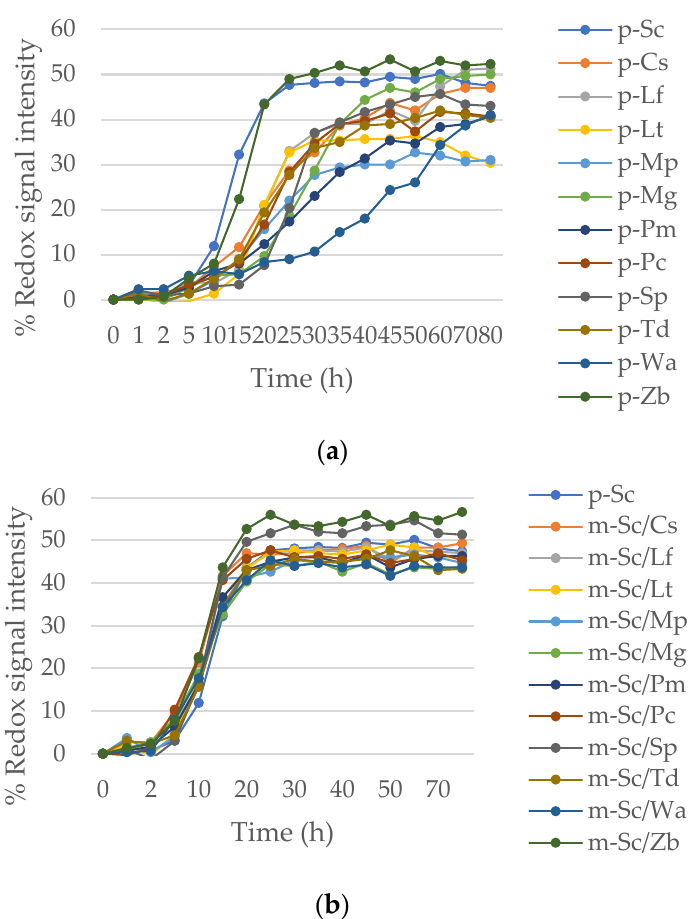
Figure 5. Metabolic rate as redox signal intensity of non- Saccharomyces strains and S. cerevisiae under alcohol degree stress induced by 13% ethanol in: ( a ) pure culture and ( b ) mixed culture 1:1 with S. cerevisiae . Pure culture of S. cerevisiae (p-Sc) was considered as control in both cases. 3.3. Small Scale Fermentations with Candida stellata CLI 920 and Schizosaccharomyces Pombe CLI 1085 in Mixed Culture with Saccharomyces cerevisiae CLI 519 under Osmotic Stress Microvinifications were carried out in a synthetic medium with the non- Saccharomyces species, C. stellata and S. pombe inoculated at 50% together with S. cerevisiae in a control medium and in a high osmotic pressure medium generated with 30% of sorbitol. The fermentative kinetic in standard medium (Figure 6a) indicates that the fermentation process finished from 47 h, except for pure culture of S. pombe (p-Sp). The control p-Sc and both mixed cultures presented a kinetic pattern very similar. By contrast, the non- Saccharomyces pure cultures (p-Cs and p-Sp) presented a slow fermentation, especially for p-Sp was more long-delayed and